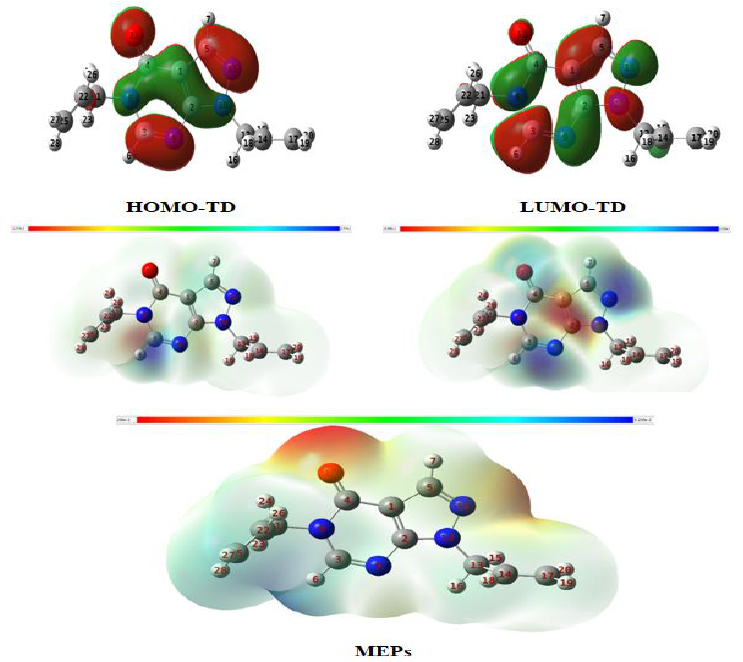
Figure 7. Minimized molecular structure, FMO, and MEP plots for PPD specie in the aqueous phase using the DFT/BLYP method with 6-31G(d, p) basis set.